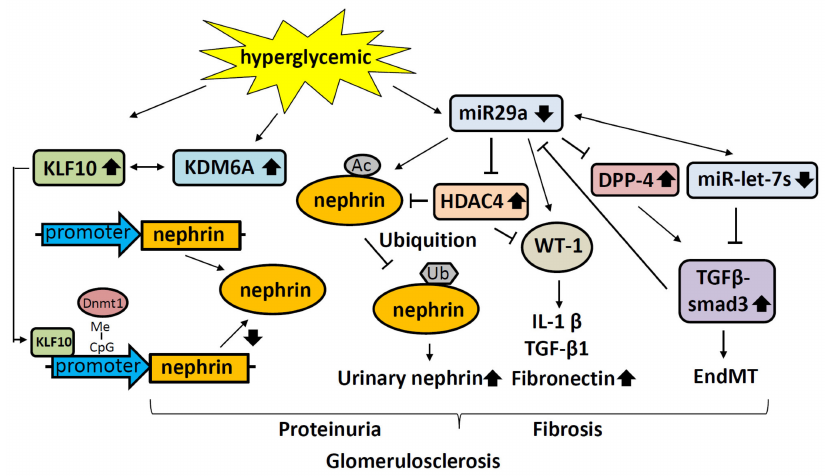
Figure 3. Hyperglycemia-induced nephrin modification induces glomerulosclerosis. Ac: acetylation; Dnmt1: DNA methyltransferase 1; EndMT: endothelial-to-mesenchymal transition; HDAC4: histone deacetylase 4; IL-1 β : Interleukin-1 β ; KDM6A: lysine-specific demethylase; KLF 10: Kr ϋ ppel-like factor 10; Me: methylation; TGF- β : Transforming growth factor β ; Ub: ubiquitination; WT1: